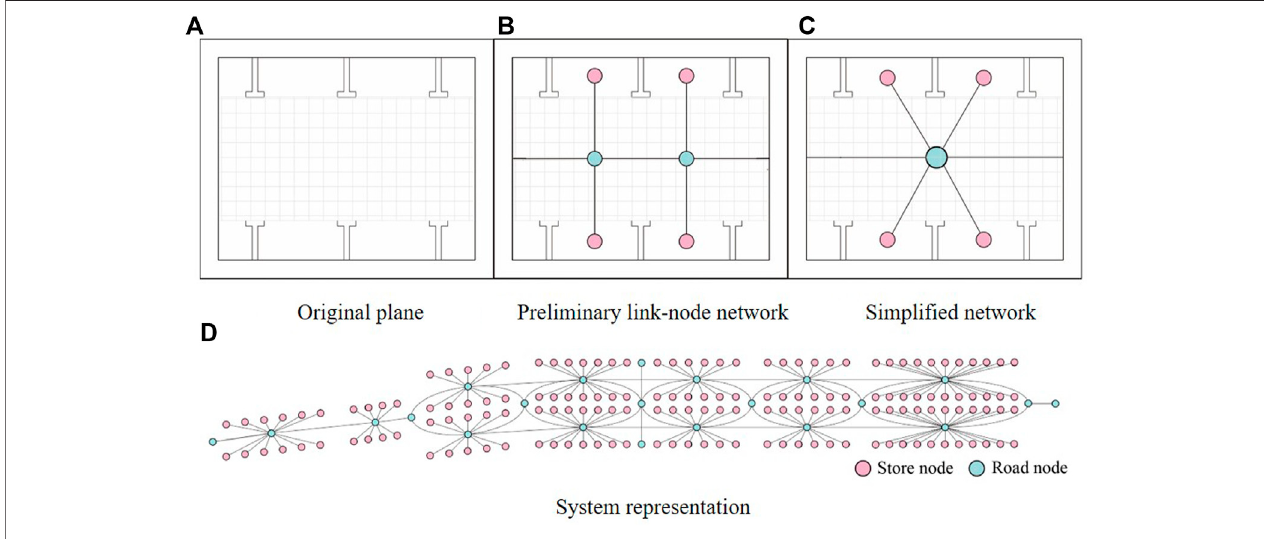
FIGURE 3 | System representation of study area: (A) original plane; (B) preliminary link-node network; (C) simpli fi ed network; (D) system representation.